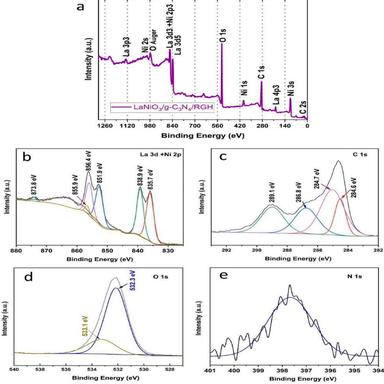
(a) High resolution and XPS spectra of LaNiO3/g-C3N4@RGH, (b) La 3d + Ni 2p (c) C 1c (d) O 1s and (e) N 1s.